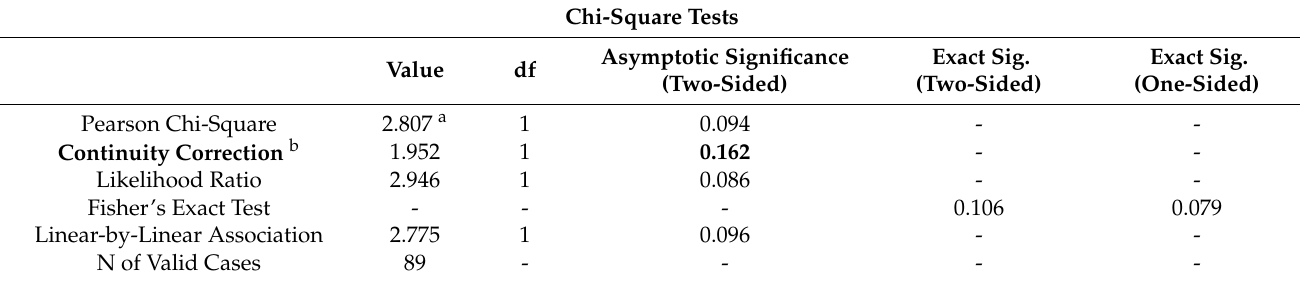
Table 11. Results of Chi-square test for variables role and future use of